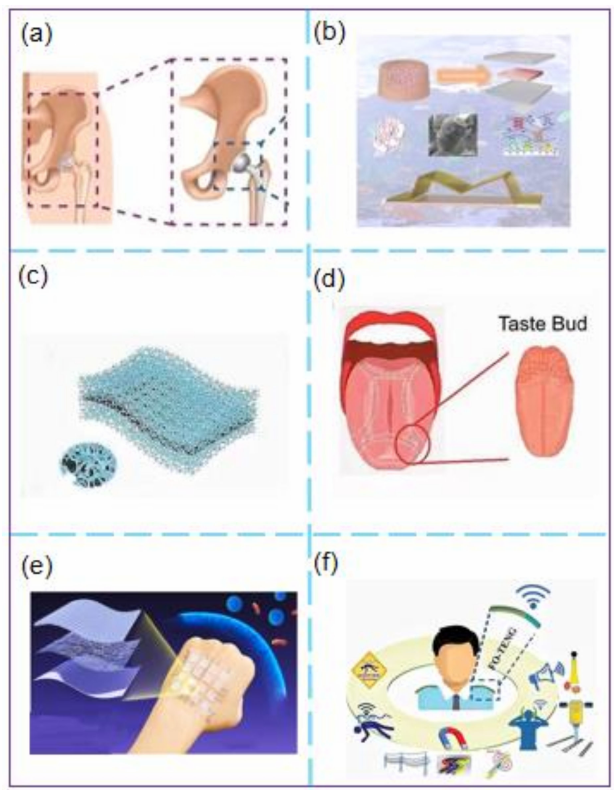
Figure 7. ( a ) Schematic illustration of the wear debris sensor [122]; ( b ) Stretchable and Flexible tremor sensor [123]; ( c ) Schematic illustration of the T-Foam [124]; ( d ) Schematic illustration of the taste receptor: taste bud [127]; ( e ) Schematic illustration of a transparent and antibacterial electronic skin is designed for sensitive tactile sensing [129]; ( f ) Schematic illustration of the hazard preventive wearable platform [133]. ( a ) Reprinted with permission, LN: 5067420140637. ( b ) Reprinted with permission, LN: 5070121150675. ( c ) Copyright 2021, John Wiley & Sons. ( e ) Reprinted with